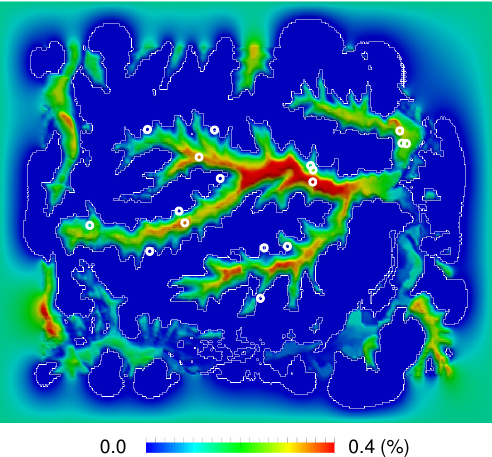
Figure 6. Design strain for level-2 ground motion (factor µ = 1.2 for all regions). White circles indicate the positions of pipeline damage.